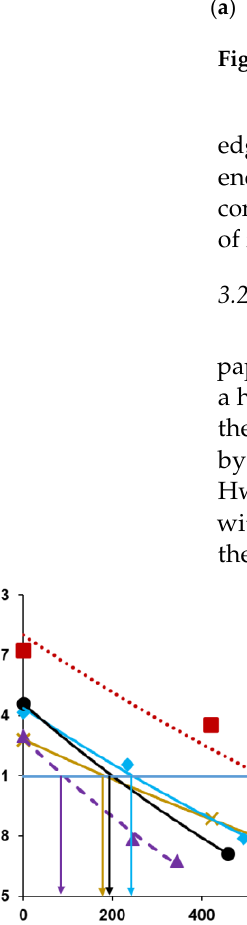
Figure 9. Effect of CEL on WRV of the mixed pulps: ( a ) PA55; ( b ) PB97.